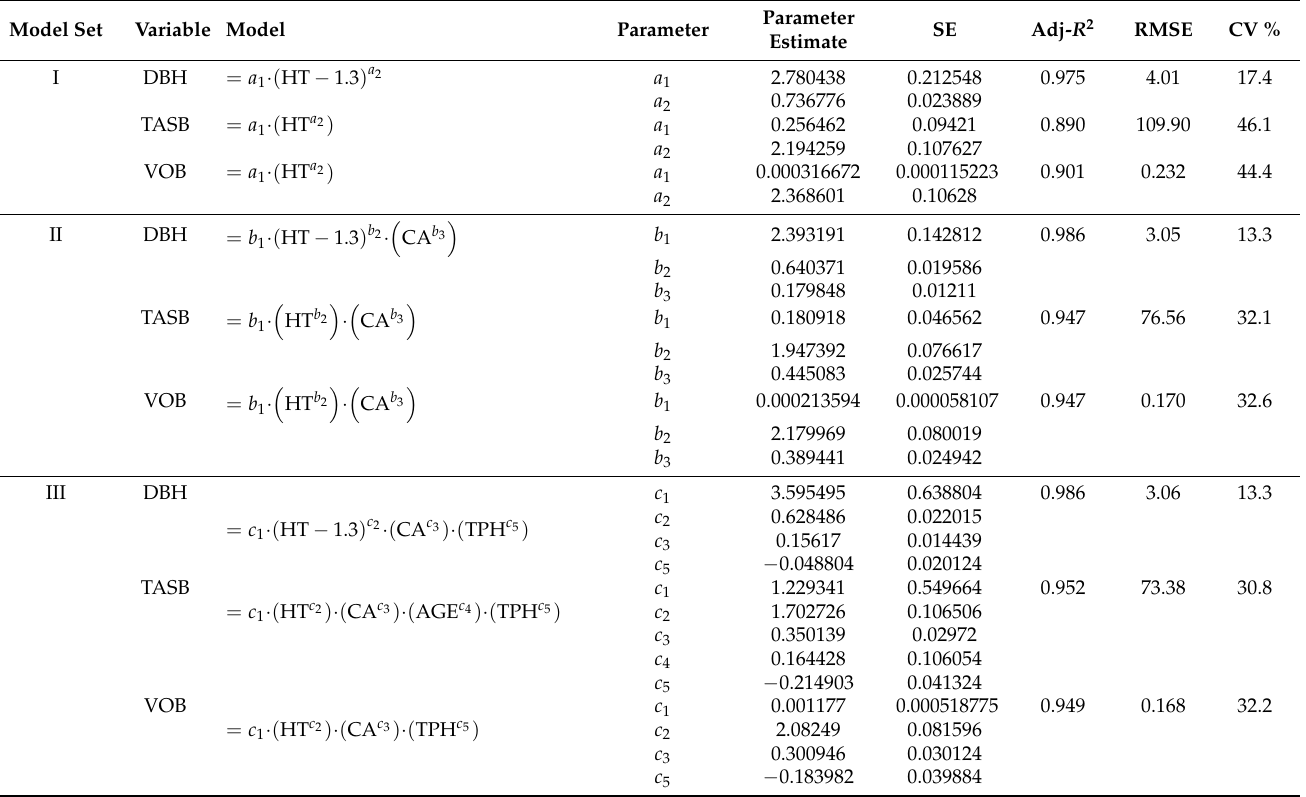
Table 4. Parameter estimates and fit statistics of the selected local and general DBH/biomass/volume functions for P. radiata trees growing in central